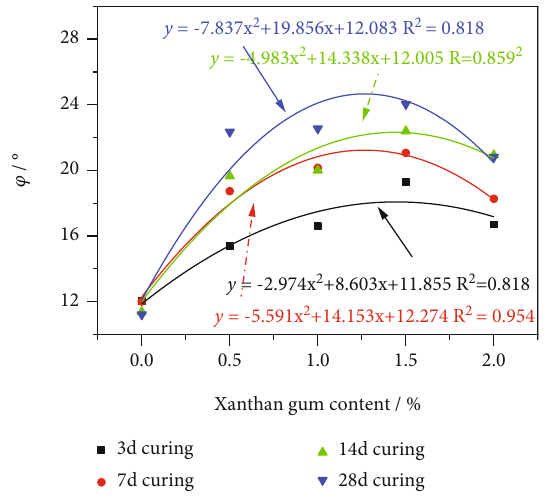
Figure 13: Relationship between xanthan gum content and internal friction angle.